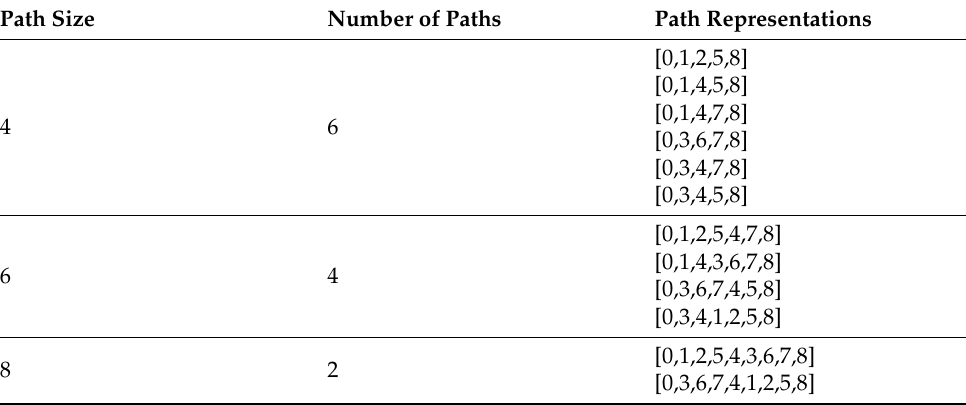
Table 1. Classification of 3 × 3 lattice paths from node 0 to node 8 according to Path Size. Path Size